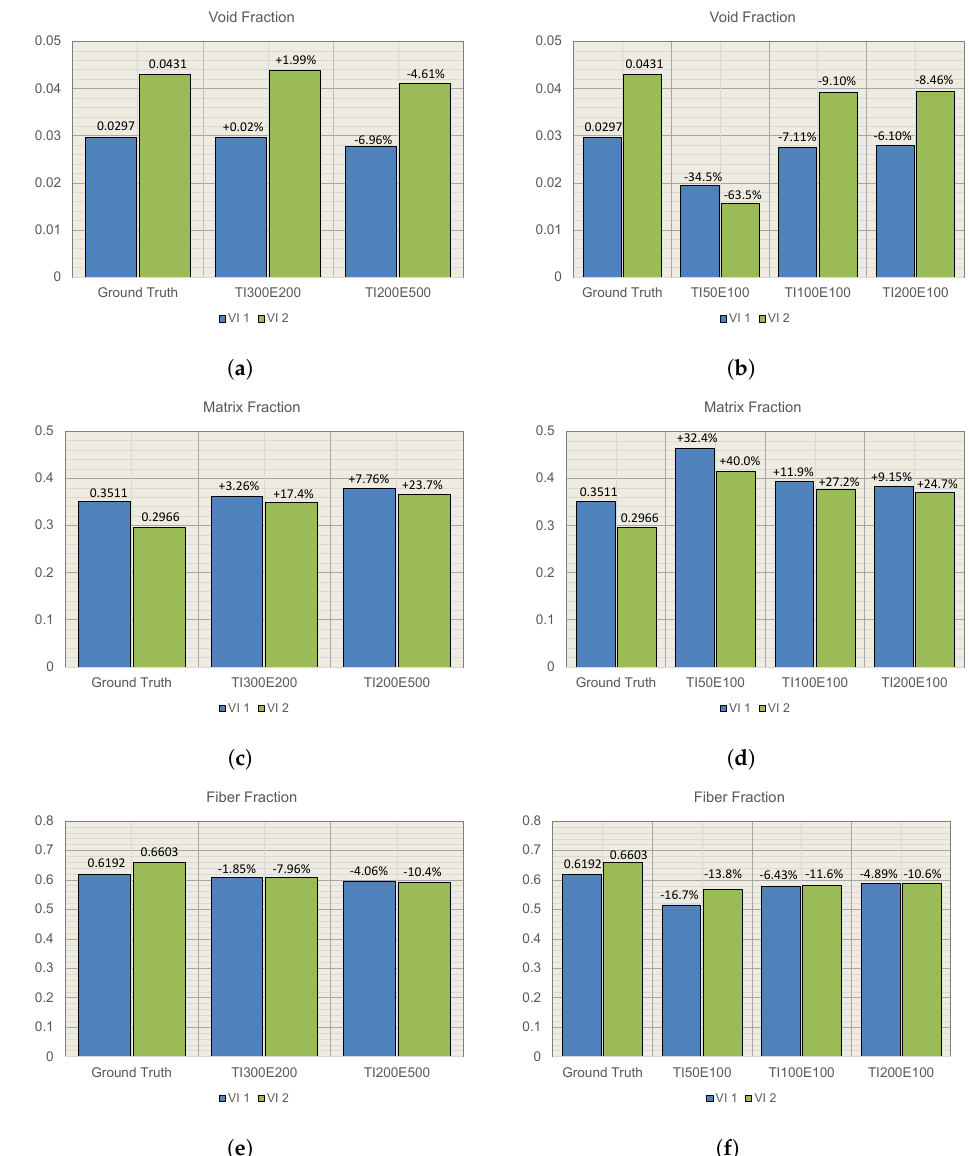
Figure 9. Comparison of constituent fractions, predicted for VI1 and VI2, and ground truth, ( a , b ) void fraction, ( c , d ) matrix fraction, and ( e , f ) fiber fraction.